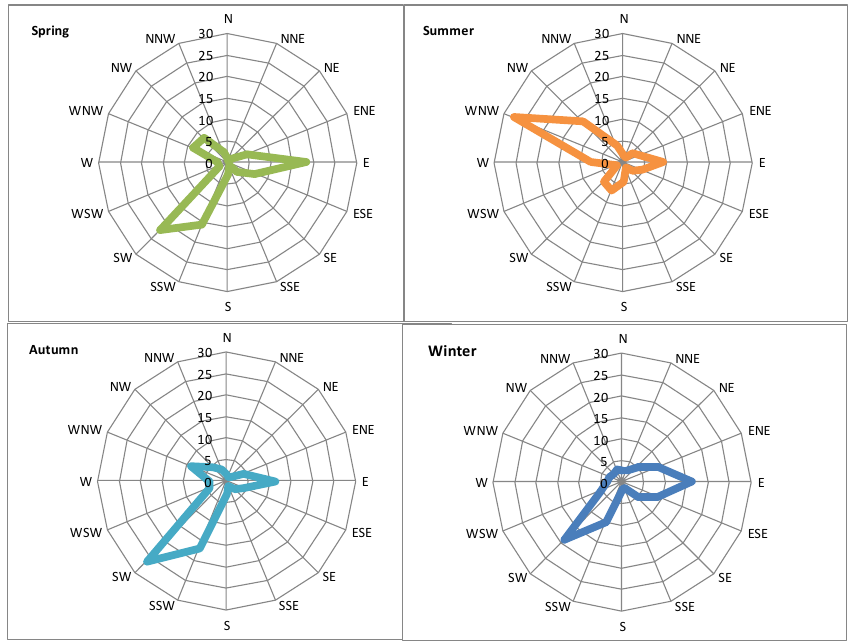
Figure 6. Rose diagrams of wind direction frequencies of the Bosten Lake Basin.